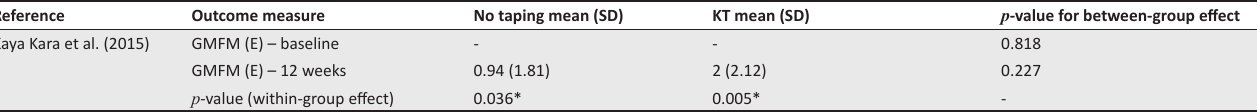
TABLE 8: Effect of kinesiology taping on standing as determined by Gross Motor Function Measure (E).